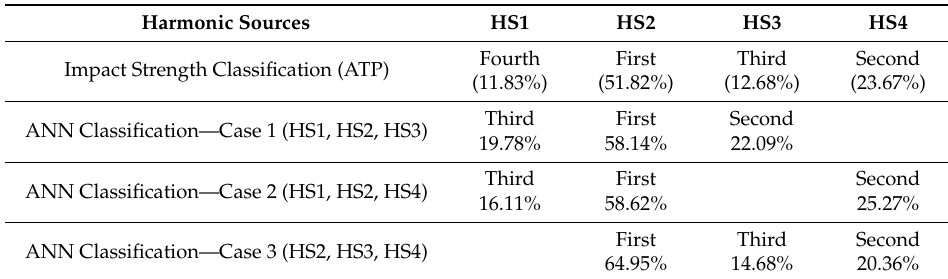
Table 4. Percent impacts on voltage harmonic distortions due to combinations of three harmonic sources and respective impact strength